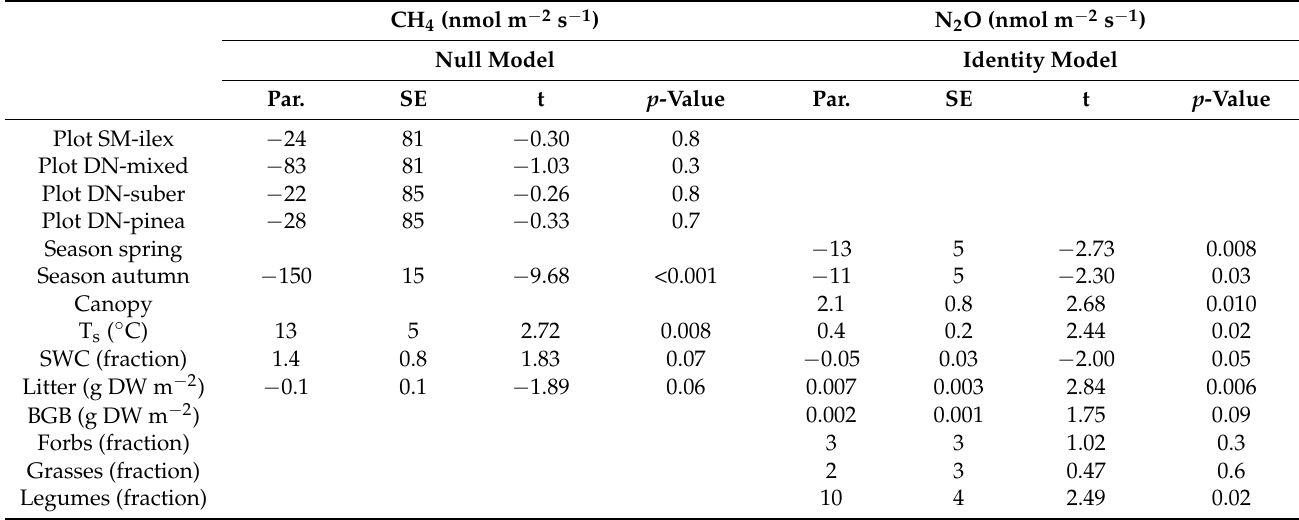
Table 3. CH 4 and N 2 O exchange diversity-interaction model results. CH 4 and N 2 O exchange as function of plot, season, canopy, soil temperature (T s ), soil water content (SWC), litter, belowground biomass (BGB), and plant functional types (forbs, grasses, and legumes) proportions. Season with spring as reference level, and canopy with open grassland (OG) as reference level. Parameter estimates (Par.), standard error (SE), t, and p -value.